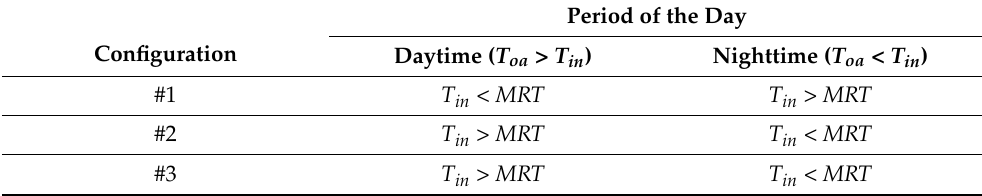
Table 6. Comparison of the damping between indoor envelope surface temperature and indoor air temperature. The mean radiant temperature ( MRT ). Indoor air temperature ( T in ). Outdoor air temperature ( T oa ). Period of the Day Configuration Daytime ( T oa > T in ) Nighttime ( T oa < T in ) #1 T in < MRT T in > MRT